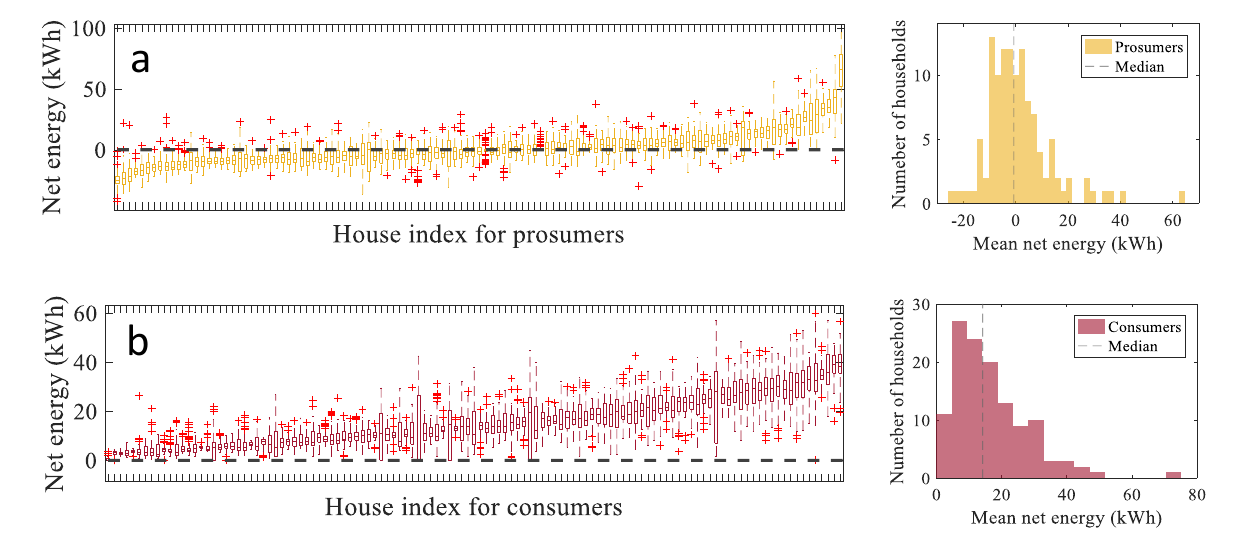
Figure 5. Distribution of net energy for ( a ) prosumers and ( b ) consumers from 9 am to 7 pm for the entire community.